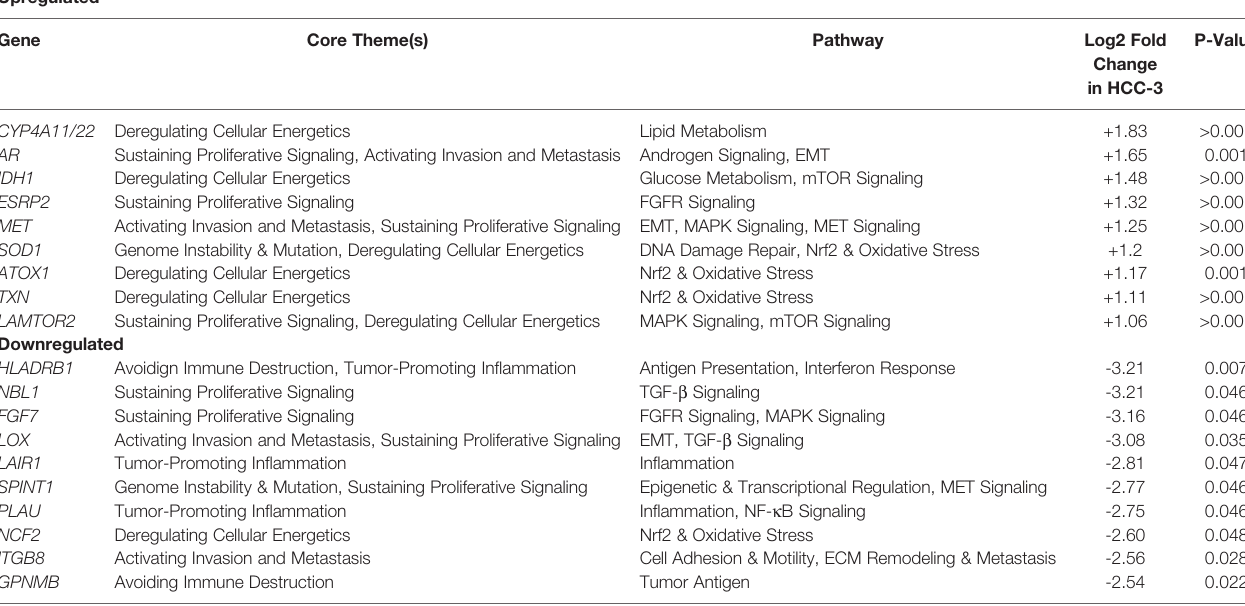
TABLE 3 | Top up and downregulated genes differentially expressed in HCC-3 subtype. Upregulated